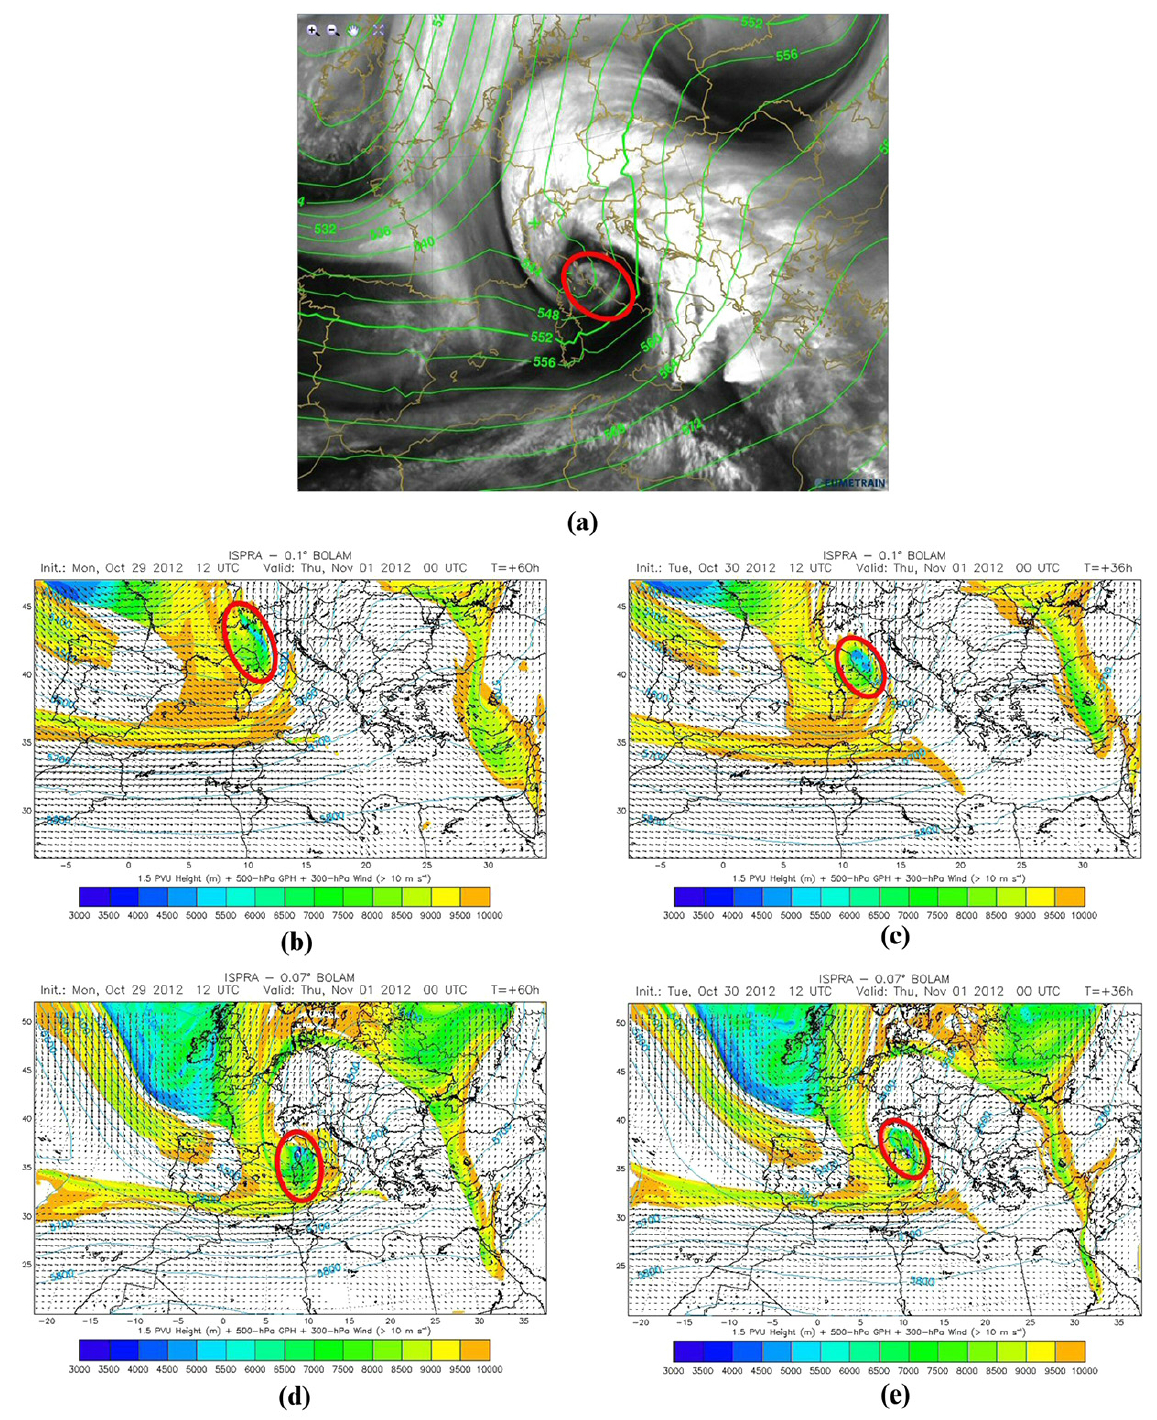
Figure 12. Synoptic-scale verification of BOLAM forecasts using MSG WV imagery at 00:00UTC of 1 November 2012; the red ellipse represents the cyclone vorticity centre. (a) MSG 6.2µWV channel image and ECMWF analysis of 500hPa geopotential (green contour lines); (b) 0.1 ◦ BOLAM forecast of 1.5PVUPV isosurface height (colour shaded), 500hPaGPH (sky blue contour lines) and 300hPa wind stream (wind speed >10ms − 1 ) ; the forecast initialised at 12:00UTC of 29 October 2012. (c) As in (b) , but for the forecast initialised at 12:00UTC of 30 October 2012. (d) As in (b) , but for the 0.07 ◦ BOLAM forecast. (e) As in (c) , but for the 0.07 ◦ BOLAM